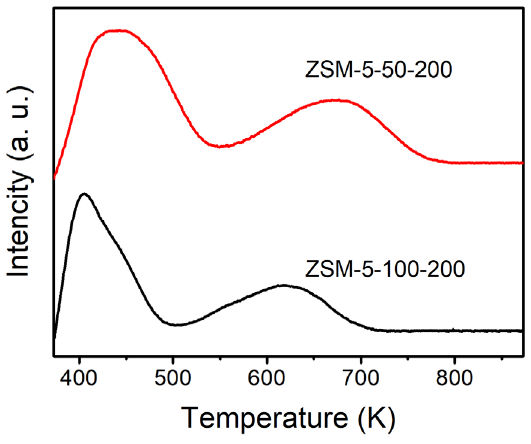
Figure 12. NH 3 ‐ TPD profile of ZSM ‐ 5 ‐ 50 ‐ 200 and ZSM ‐ 5 ‐ 100 ‐ 200. Figure 12. NH 3 -TPD profile of ZSM-5-50-200 and